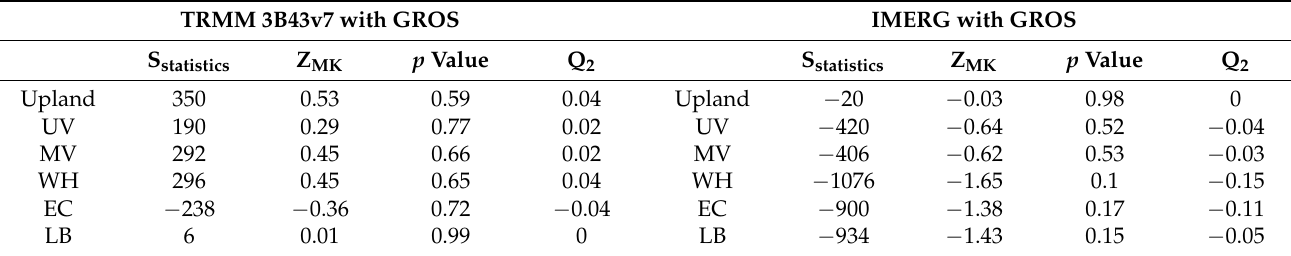
Table 6. Mann–Kendall (MK) trend test and Sen’s slope (Q 2 ) result of satellite